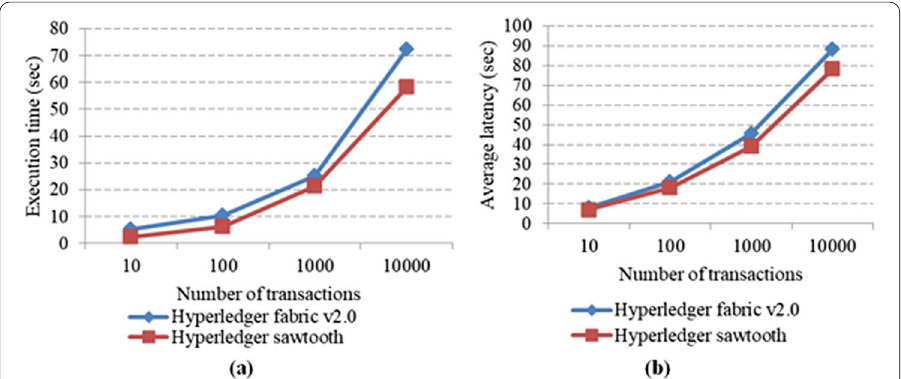
Fig. 9 Blockchain performance for validation process: a execution time and b average latency. Performance of blockchain that is third phase of the system is presented in graphical form for validation process execution. Validation process is an operation executed by node when nodes verify blocks to add in the blockchain. a Execution time required for validation process using Hyperledger fabric 2.0 and sawtooth is represented. b Average latency required for validation process execution on system when implemented using Hyperledger v2.0 and sawtooth is graphically represented